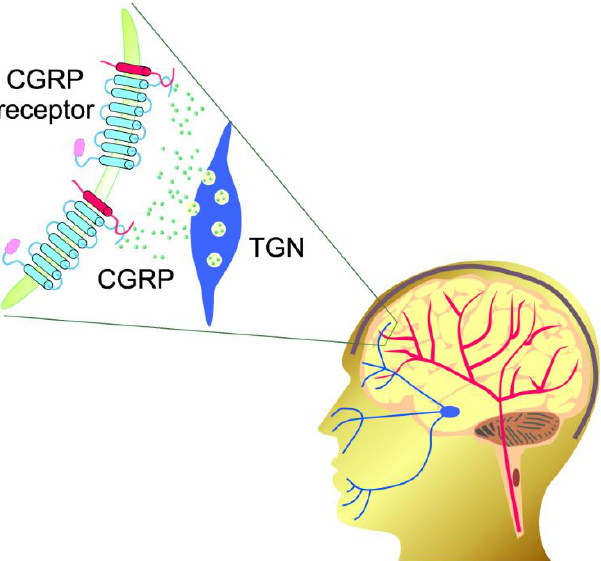
Figure 5. Calcitonin gene-related peptide (CGRP) is stored in large dense-core vesicles in the sensory nerve terminals, but after activation of the trigeminovascular system, CGRP molecules (small green objects) can be released at trigeminal nerve (TGN, blue) endings and bind the CGRP receptors present in both TGN and cerebral blood vessels (red).